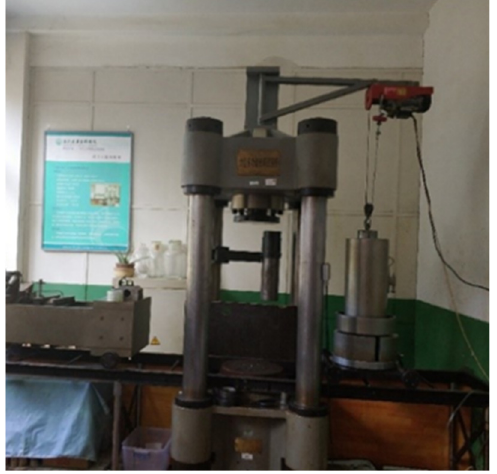
Figure 4. WDT-1500 large multifunctional material testing machine.